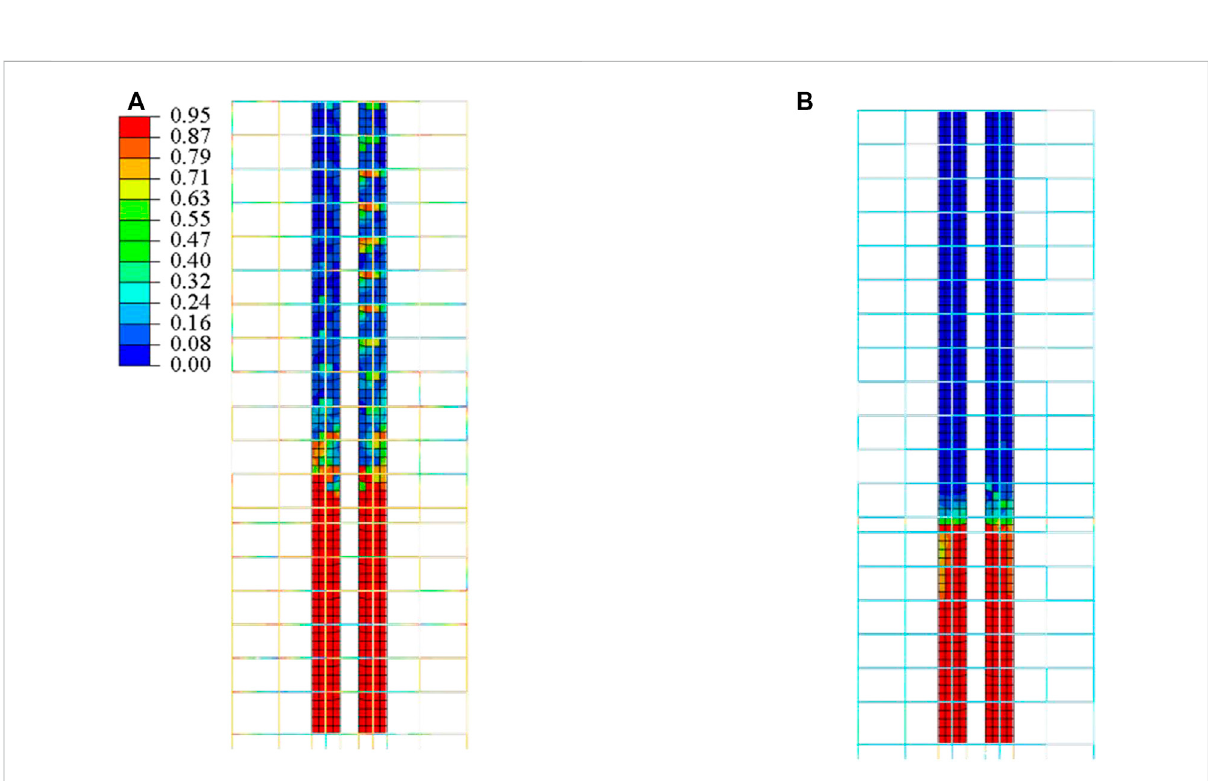
The damage of the new staggered story isolated structure: (A) Tensile damage, (B) Compressive damage.